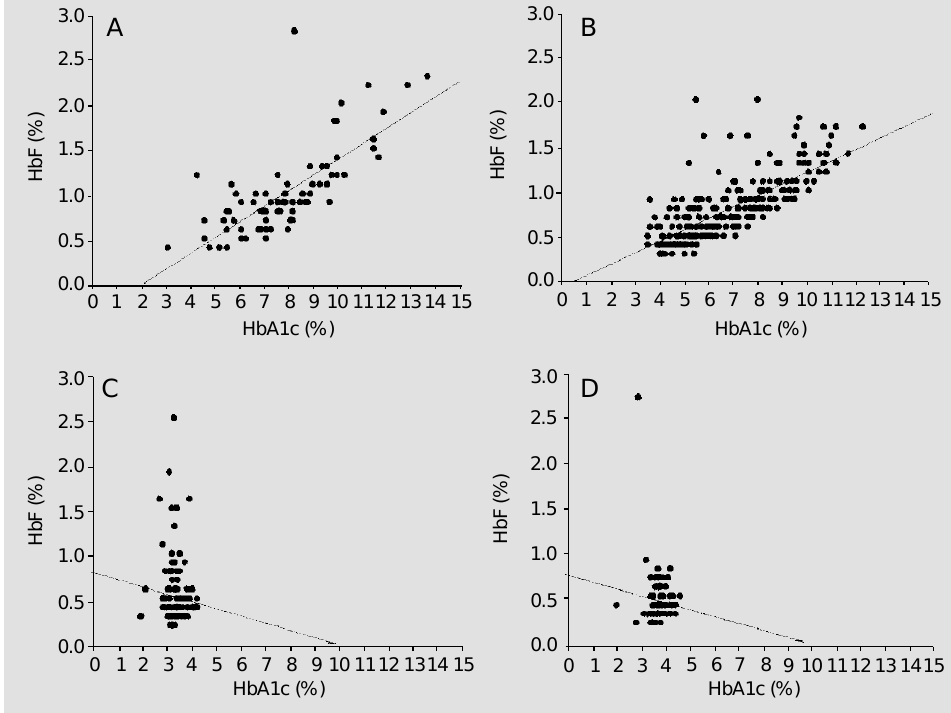
Figure 2 - Correlations between HbA1c and HbF levels in (A) type 1 diabetes subjects (R 2 = 0.57, P<0.0001), (B) type 2 diabetes subjects (R 2 = 0.58, P<0.0001), (C) control group 1 (R 2 = 0.007, P = 0.36), and (D) control group 2 (R 2 = 0.012, P =